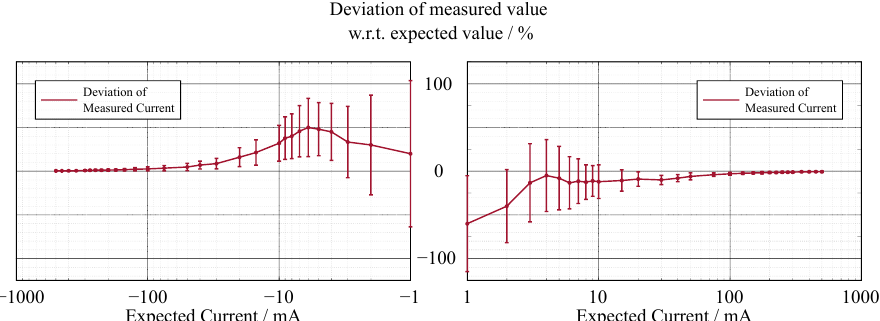
Figure 4. Relative deviation of the current as measured by the sensor box with regard to the ex- pected